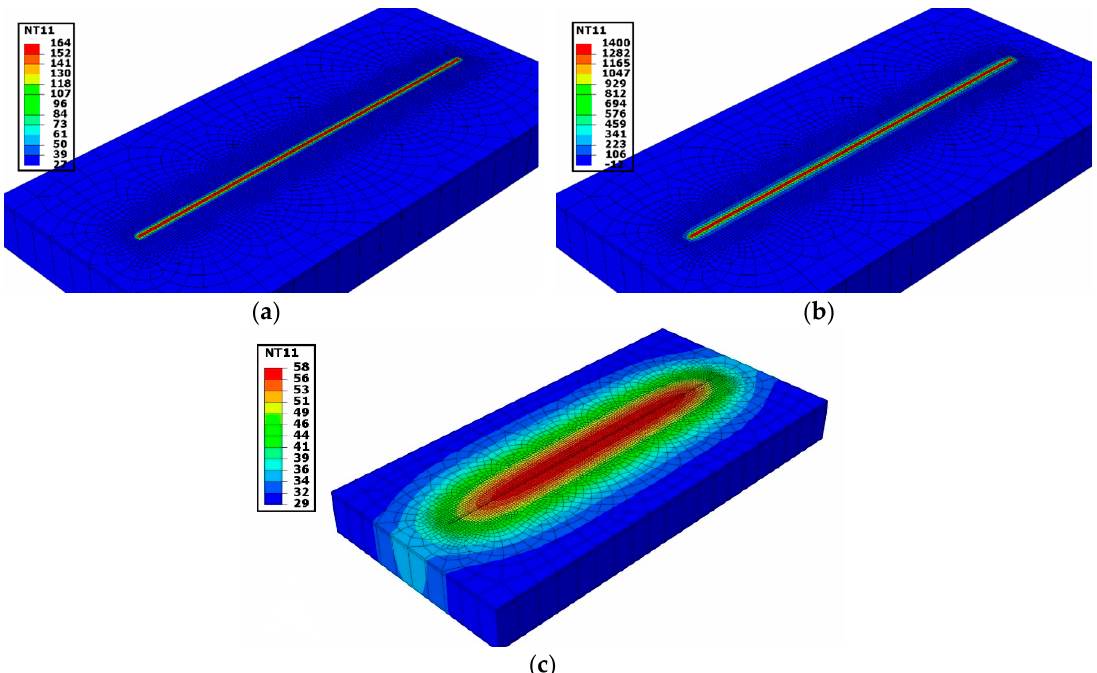
Figure 12. Temperature evolving during thermal cycle heat input method for single-track simulation. ( a ) 2.358173 s, ( b ) 2.6155 s and ( c ) 5.7 s